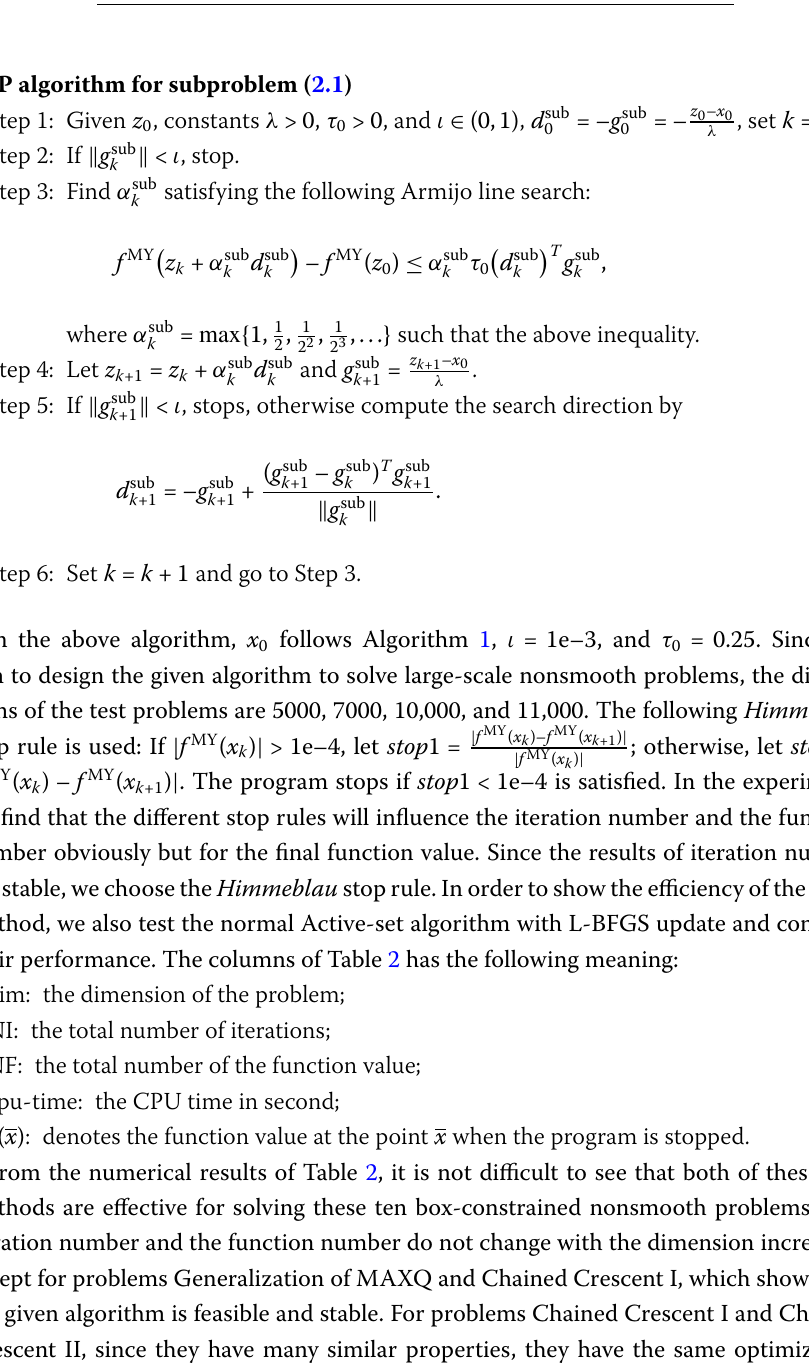
PRP algorithm for subproblem